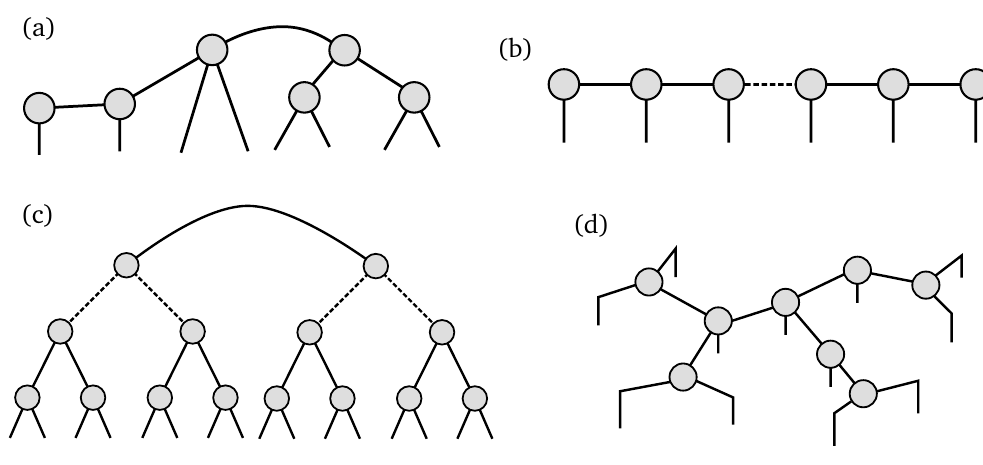
Figure 24: Loop-free TN geometries: (a) a generic tree tensor network, (b) an MPS, (c) a binary tree tensor network (bTTN), (d) a molecular TTN, shaped according to an arbitrary loop-free graph geometry, finding application in physical